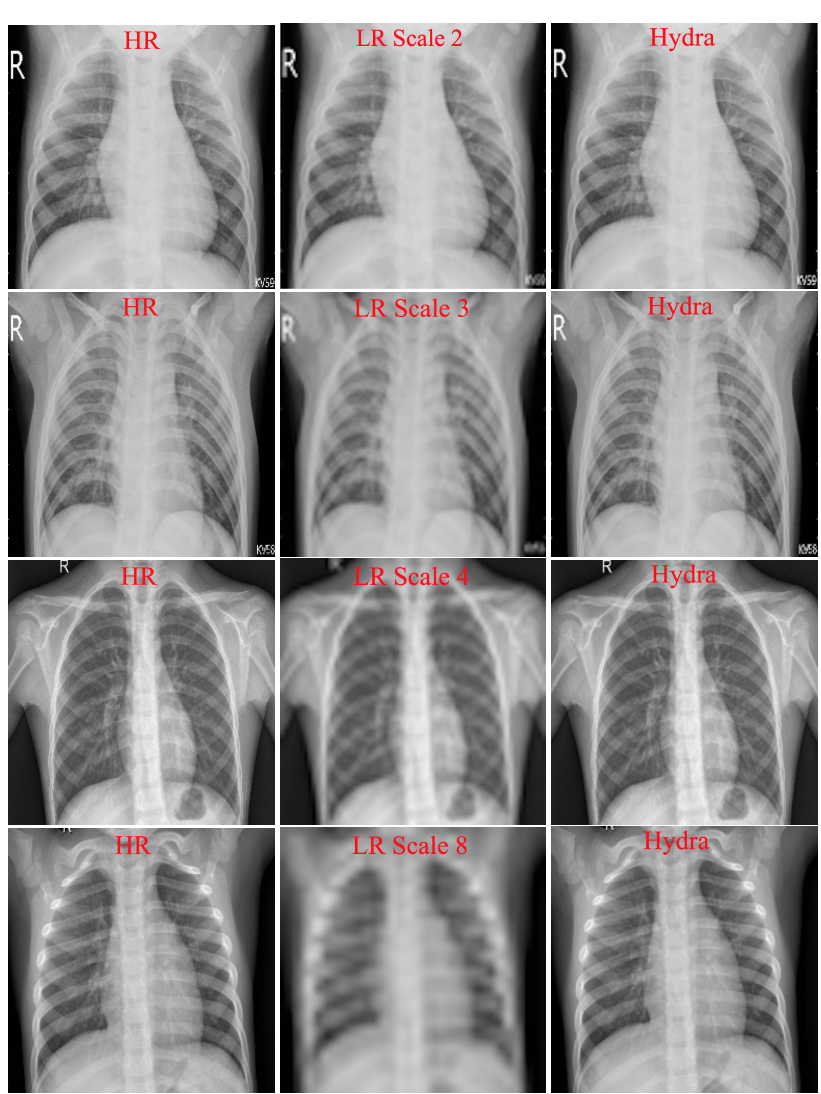
Figure 3. Examples of reconstructed SR images. First column: original HR images. Second column: downsampled input LR images. Third column: reconstructed images obtained using the proposed SISR model ( Hydra